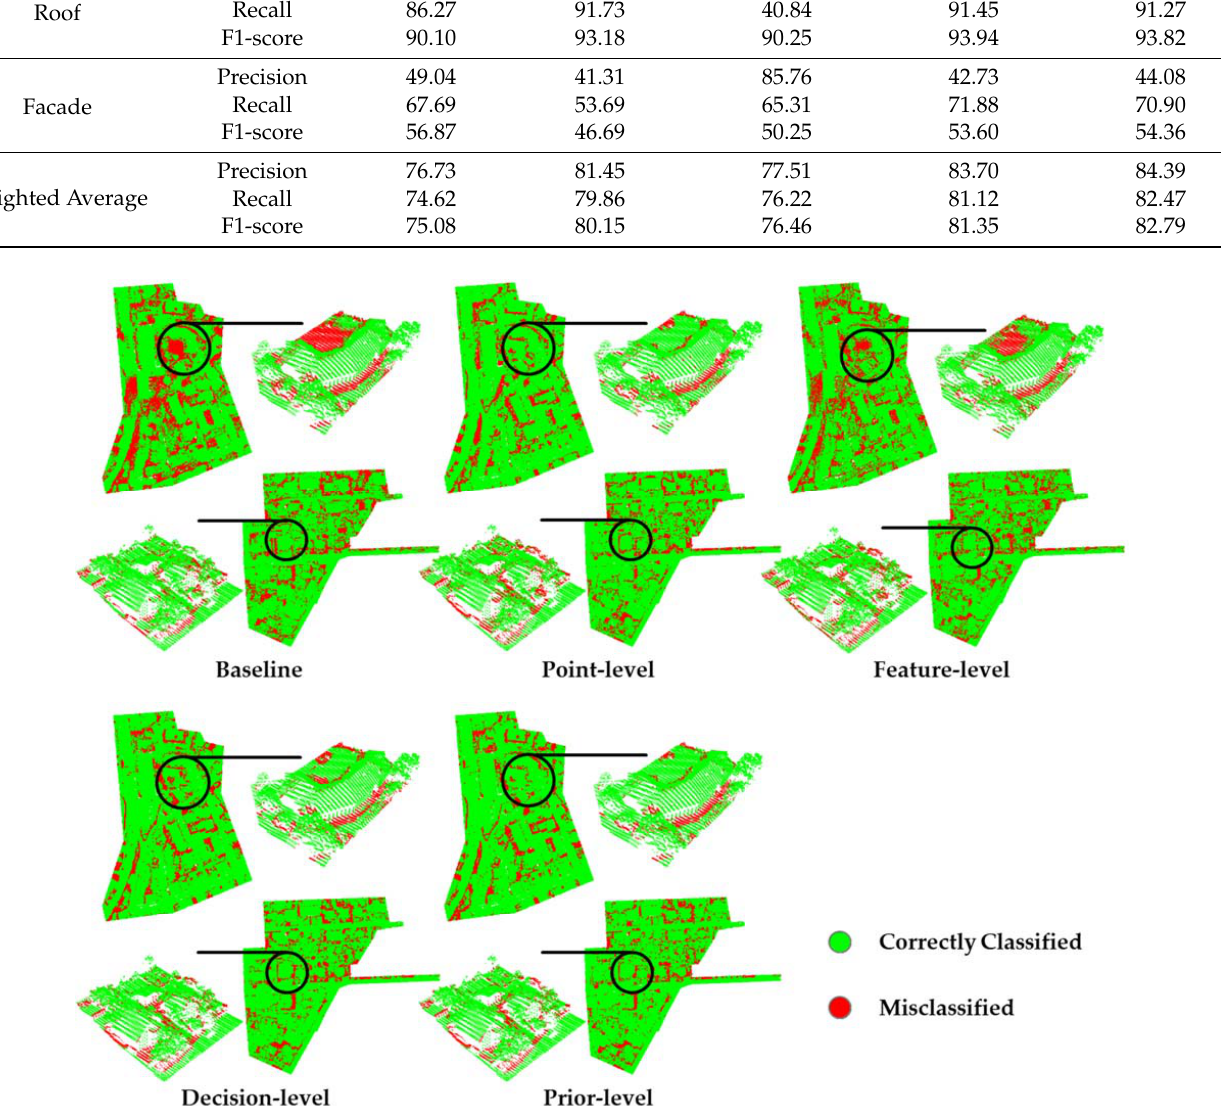
Figure 6. Error distributions from the results of the baseline and four fusion strategies.